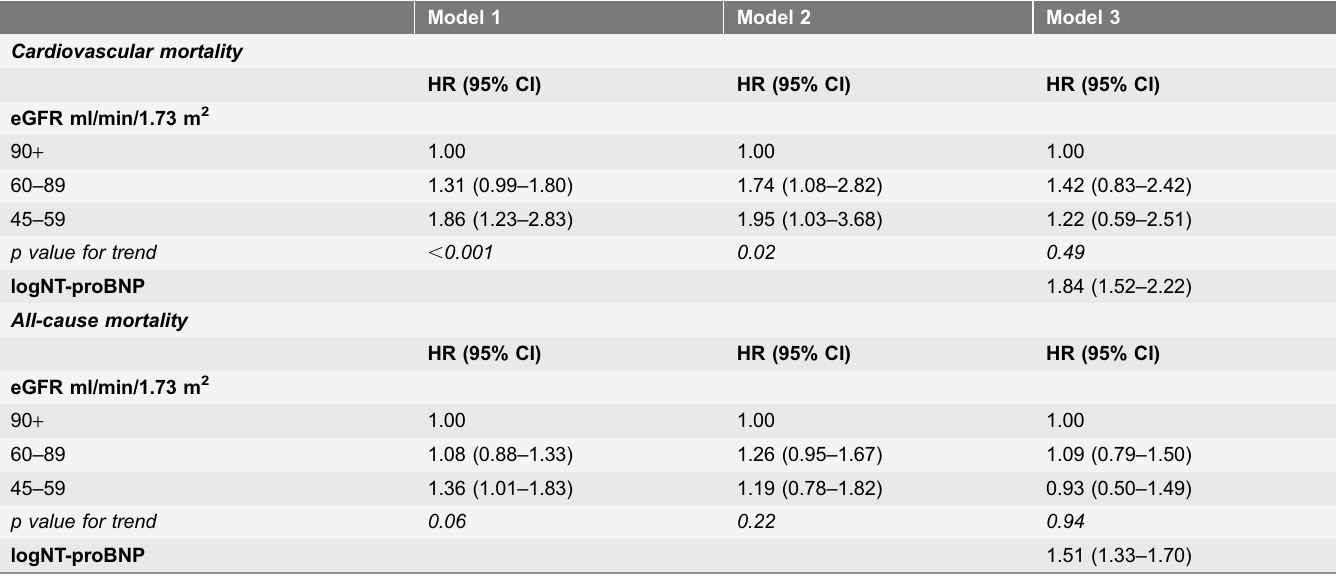
Table 2. Results of Cox-regression analysis of variables associated with 6-years all-cause and cardiovascular mortality in people with type 2 diabetes of the Casale Monferrato